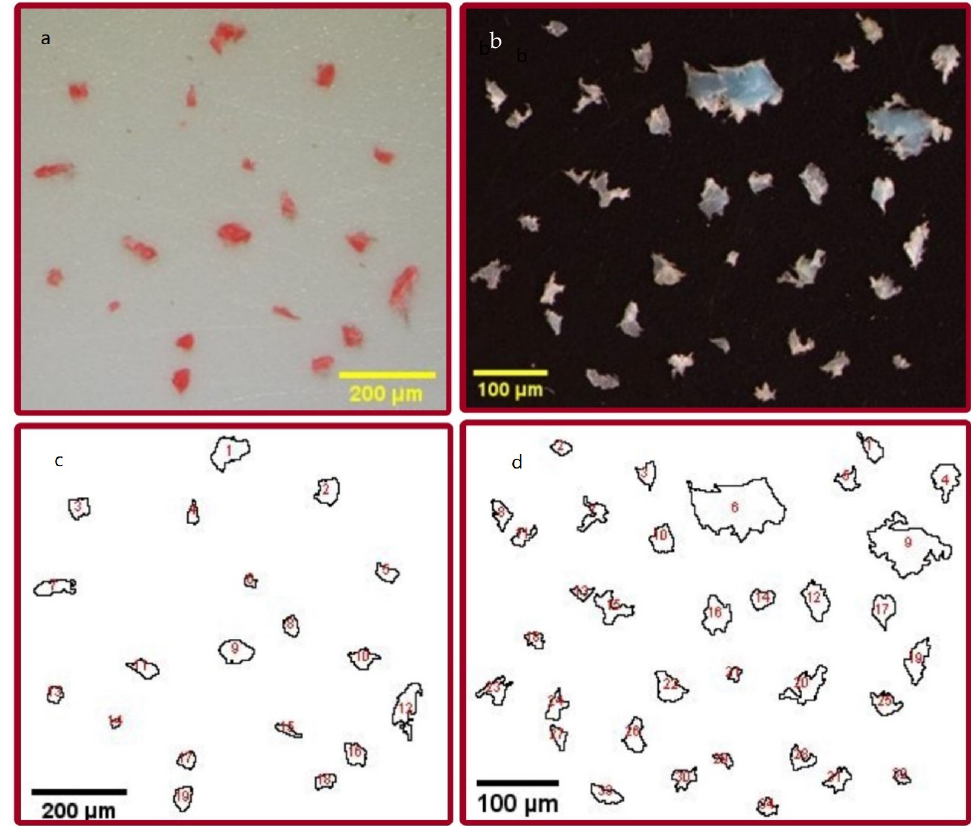
Figure 2. Original photos ( a , b ) and photos processed with Image J ( c , d ) of MP obtained through the digestion of ( a , c ) chicken sample 3 (C3) and ( b , d ) orange-spotted trevally